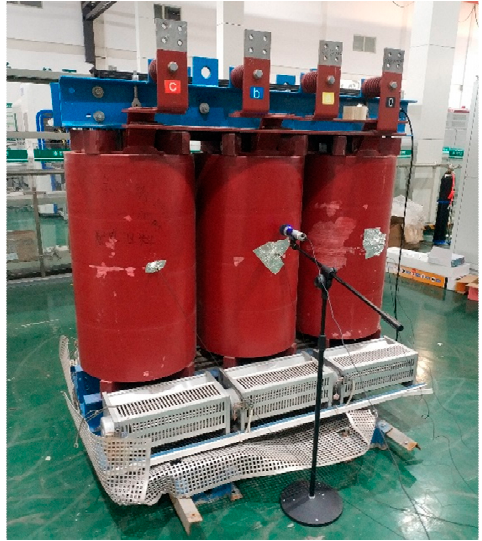
Figure 3. Layout of simulation experiment.